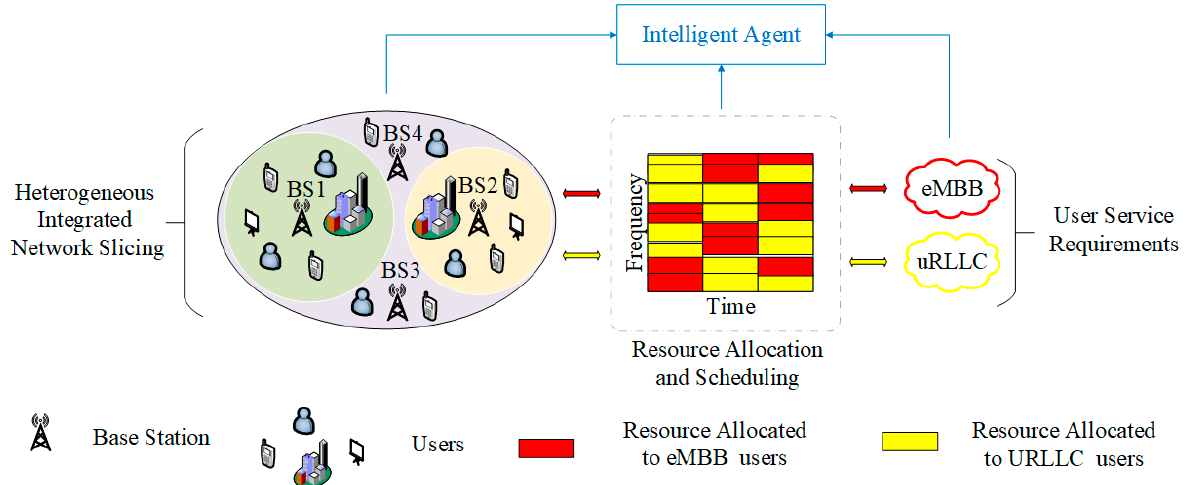
Figure 1. Network slicing scenario with multiple BSs and eMBB and URLLC users .